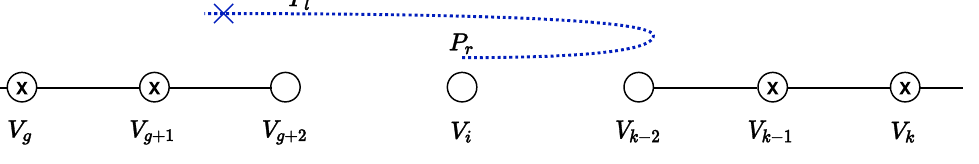
Figure 9. Pr and Pl flows are interrupted.